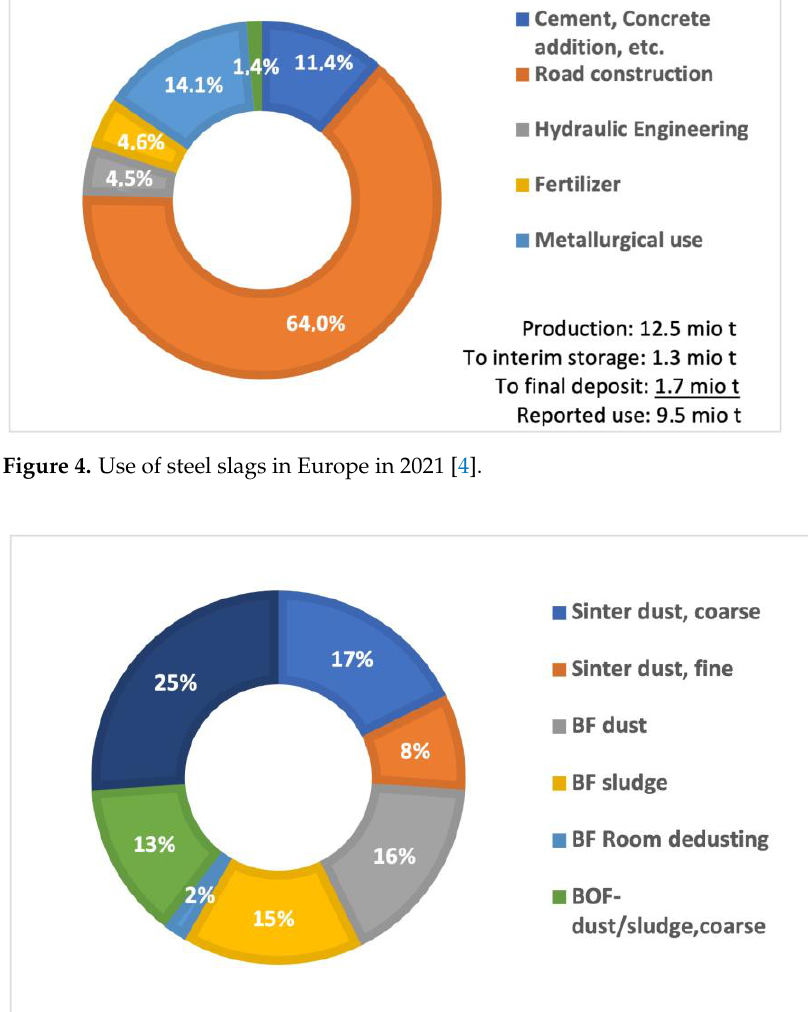
Figure 6. Industrial utilization of dust and sludge in 2018. According to EU production of crude steel (LS) in 2018 (167.7 M tonnes from BF/BOF and the EAF route), the amount of sludge and dust is estimated to be 6.8 M tonnes/year in EU [16]. Dust and sludge streams and their uses addressed are summarized in Table 1. Concerning the BF/BOF route , pellets or sinter are produced from fine ores and iron- containing residues following the reduction of ores, sinter and pellets to hot metal (pig iron) in the BF and refining in BOF and the secondary metallurgy to steel. In the European steel industry [16], dust and sludges from BF/BOF route are used in different ways [3], [17], [18]. Dust and sludge are mainly used for internal processes or moved to external sites for further processing. However, some, such as parts of the sinter dust, are still sent to landfill due to high heavy metals and metal chlorides content in fine fractions. Sinter dust and sludge are mainly recovered within the integrated steel plant, and a part is recy- cled back to the sinter plant, where it is used as sinter raw material. The rest is landfilled, as mentioned above. BF dust (coarse) can be internally used due to its high iron carbon content (mixed and granulated in sinter raw material, pelletized/briquetted in BF burden